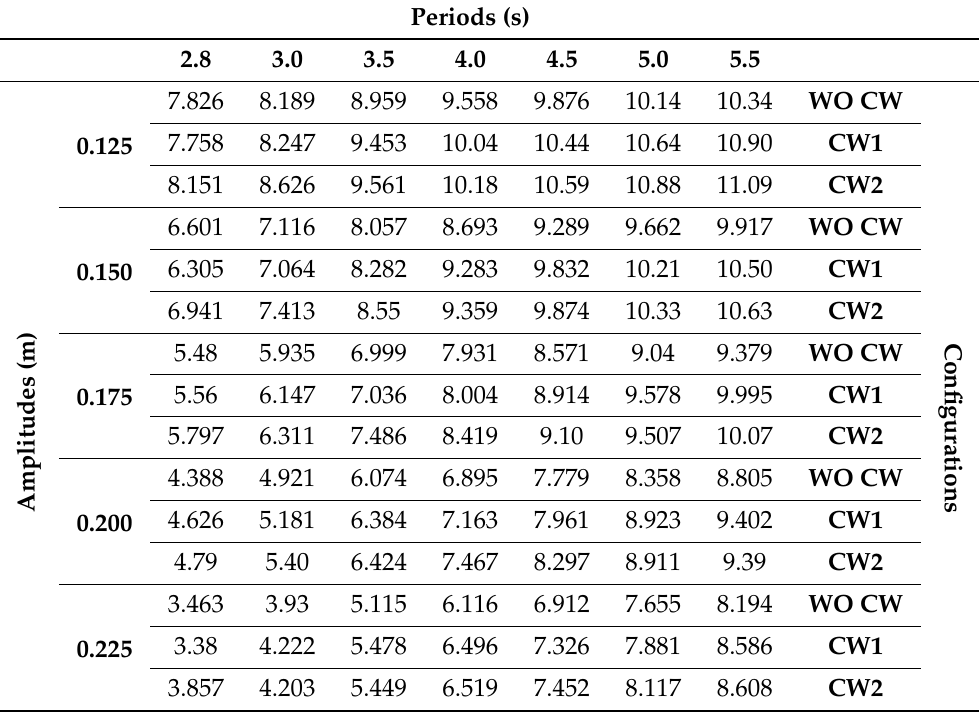
Table 9. Minimum fairlead tension in N for all the test matrix and configurations. Notation WO CW, CW1 , and CW2 denotes mooring line without clumped weight, mooring line with clumped weight (Configuration 1) and mooring line with clumped weight (Configuration 2),